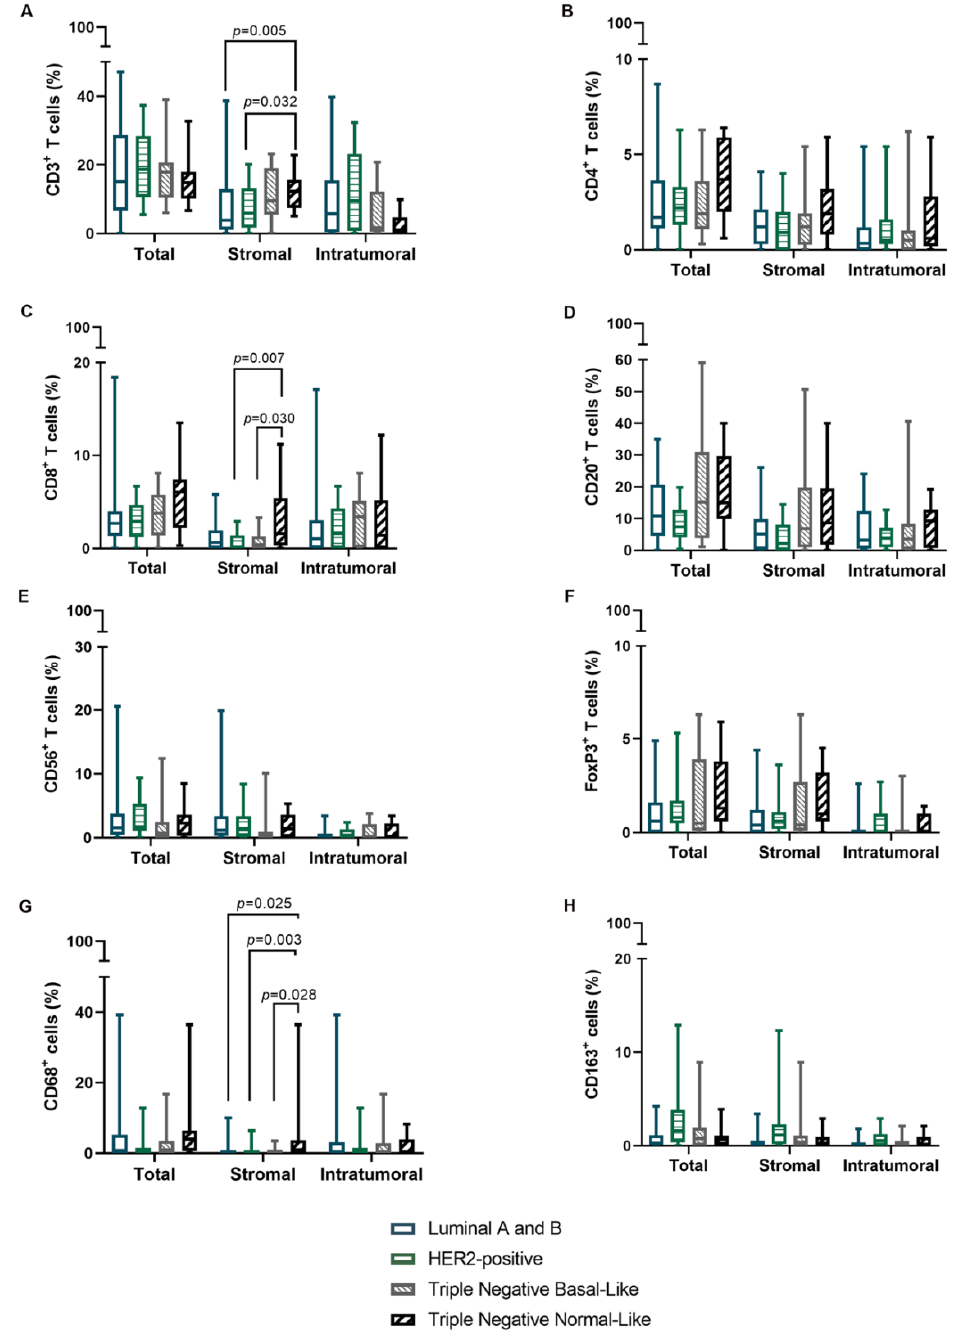
Figure 3. The percentage of stromal CD3 + and CD8 + TILs and CD68 + TAMs is increased in the tumor microenvironment of Triple Negative Normal-Like mammary carcinomas. Box plot with minimum and maximum values of ( A ) CD3 + , ( B ) CD4 + , ( C ) CD8 + , ( D ) CD20 + , ( E ) CD56 + , ( F ) FoxP3 + , ( G ) CD68 + and ( H ) CD163 + immune cells, according to location and molecular subtype.